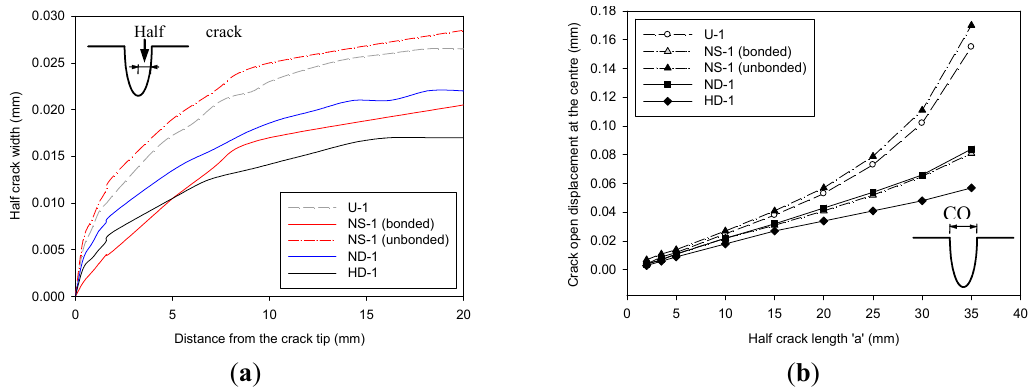
Figure 16. ( a ) Half crack width versus distance from the crack tip (a = 20 mm); ( b ) Crack opening displacement versus half crack length.